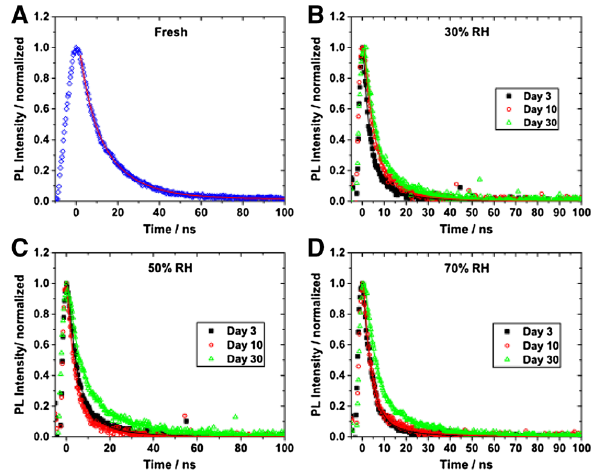
Fig. 9 a TRPL decay dynamics of the freshly prepared perovskite film. b – d TRPL decay dynamics of perovskite films stored under 30, 50, and 70 % relative humidity, respectively. Films were stored for 3 ( black squares ), 10 ( red circles ), and 30 ( green triangles ) days. PL decay lifetimes are reported in Table